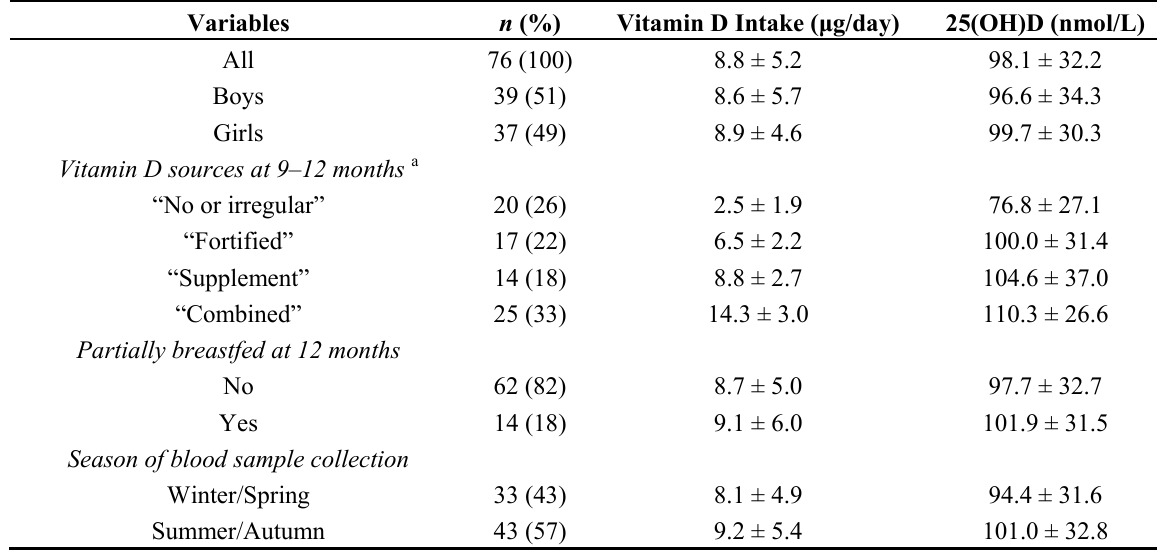
Table 1. Variables potentially associated with vitamin D intake at 9–12 months and serum 25(OH)D at 12